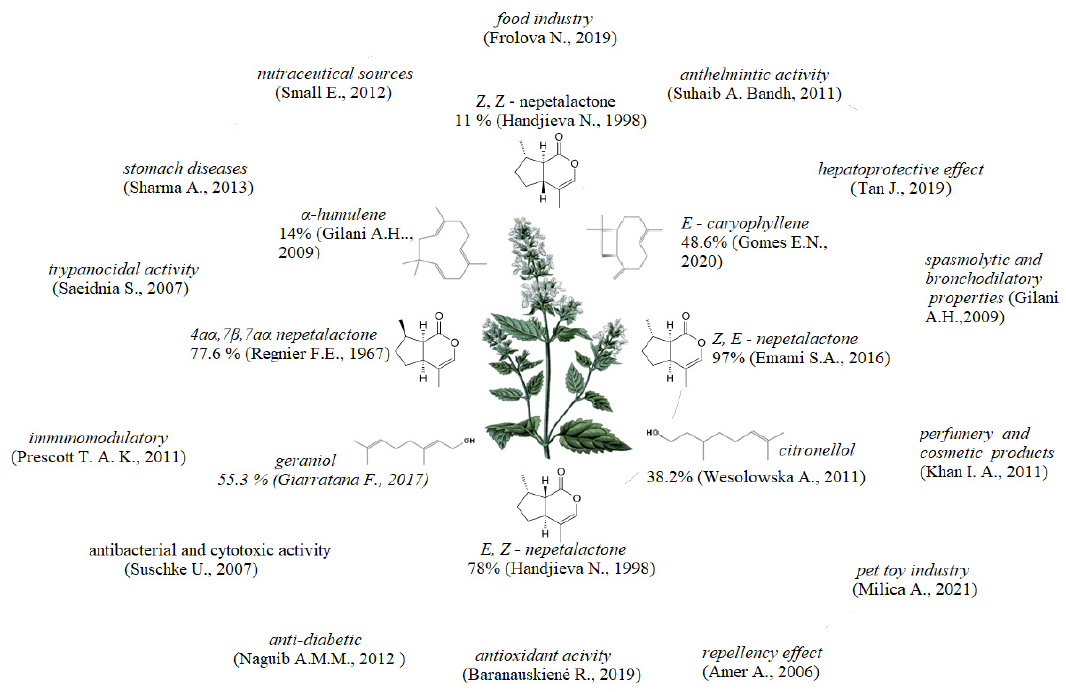
Figure 1. Main bioactive compounds in Nepeta cataria L. and their uses.